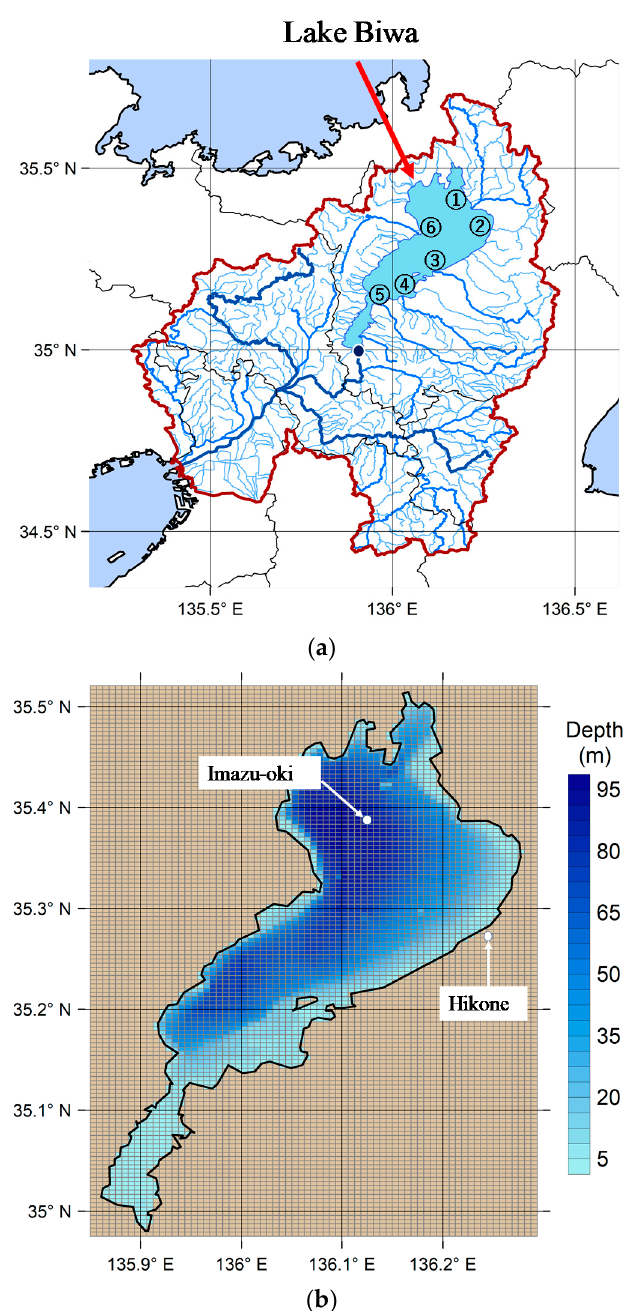
Figure 1. ( a ) The surrounding river and Lake Biwa, in the Kansai area; ( b ) calculation domain of the topography and water depth of Lake